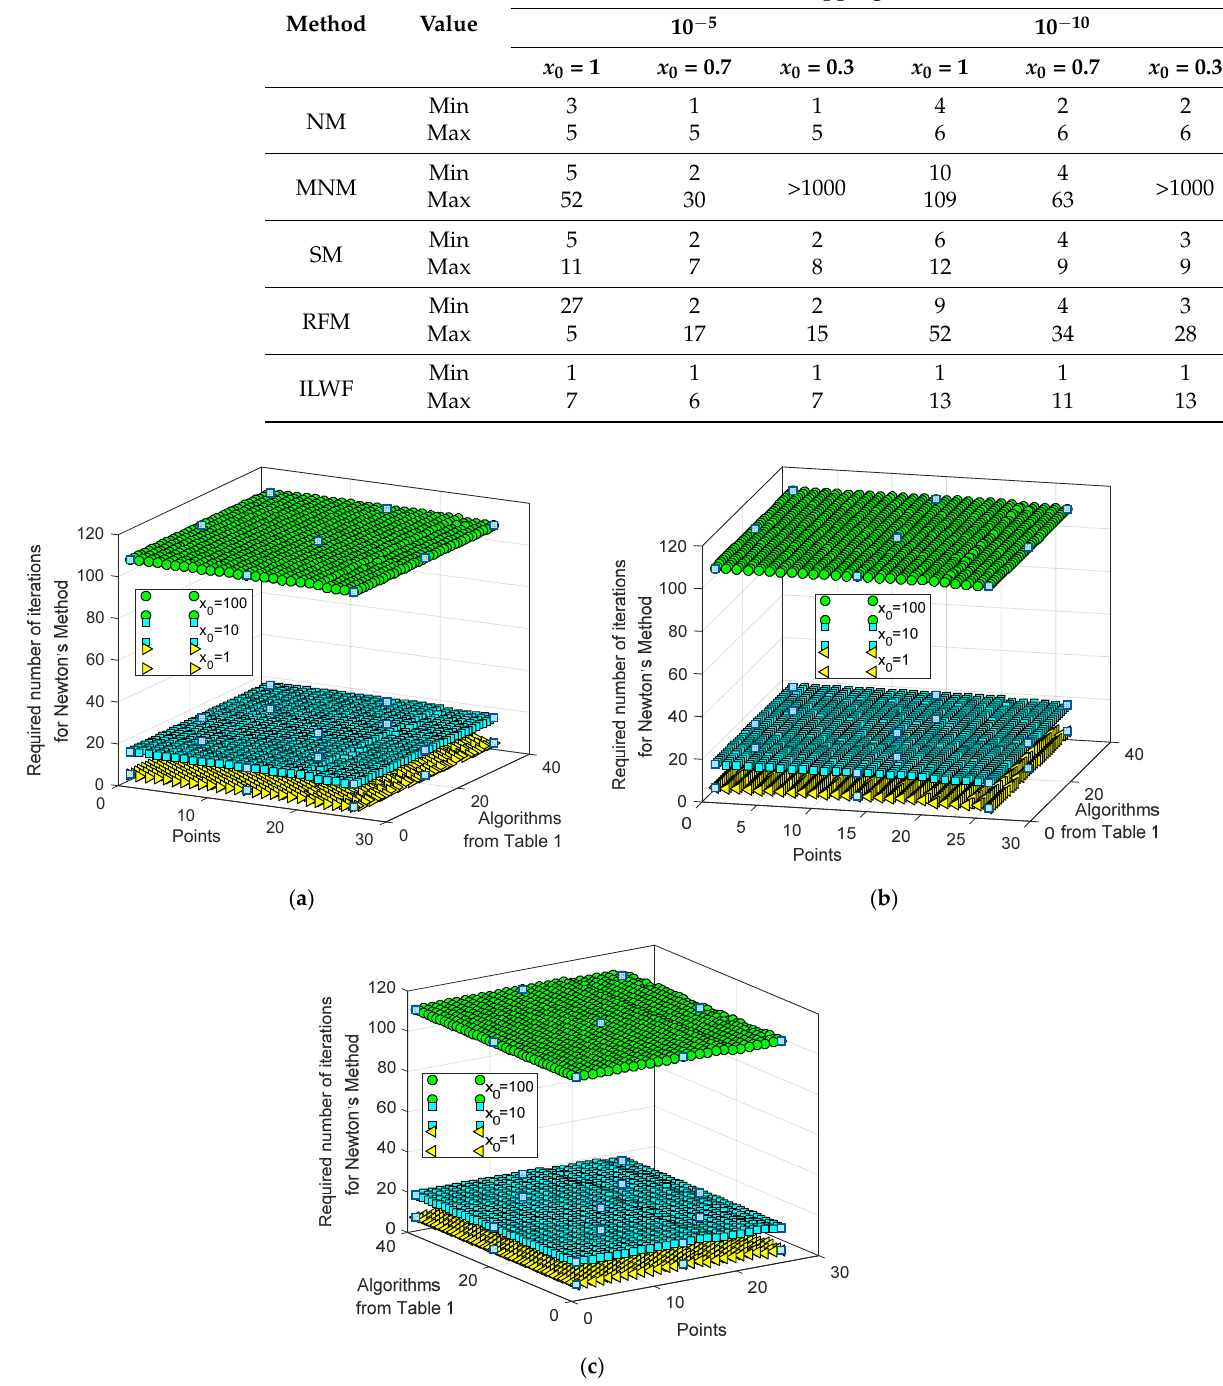
Figure 8. Required number of iterations for all voltage values with different stopping criteria using